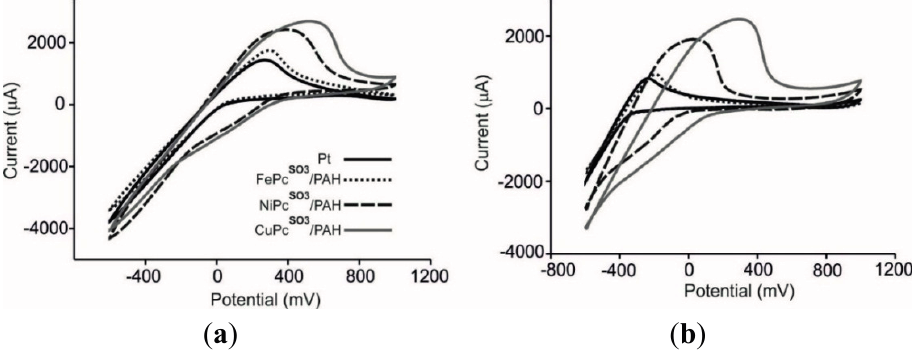
Figure 5. Voltammetric outputs of the EQCM sensors immersed in ( a ) Mencía Regadío; ( b ) Juan García